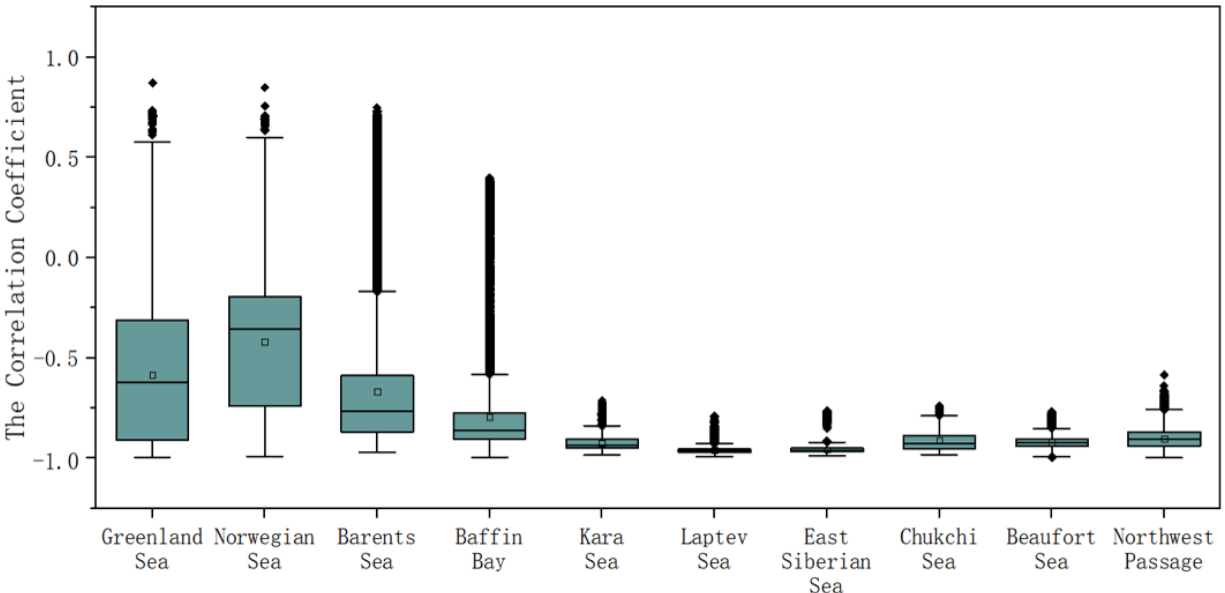
Figure 7. Correlation coefficient of SIC and SST in the Arctic marginal sea areas from 2002 to 2021.